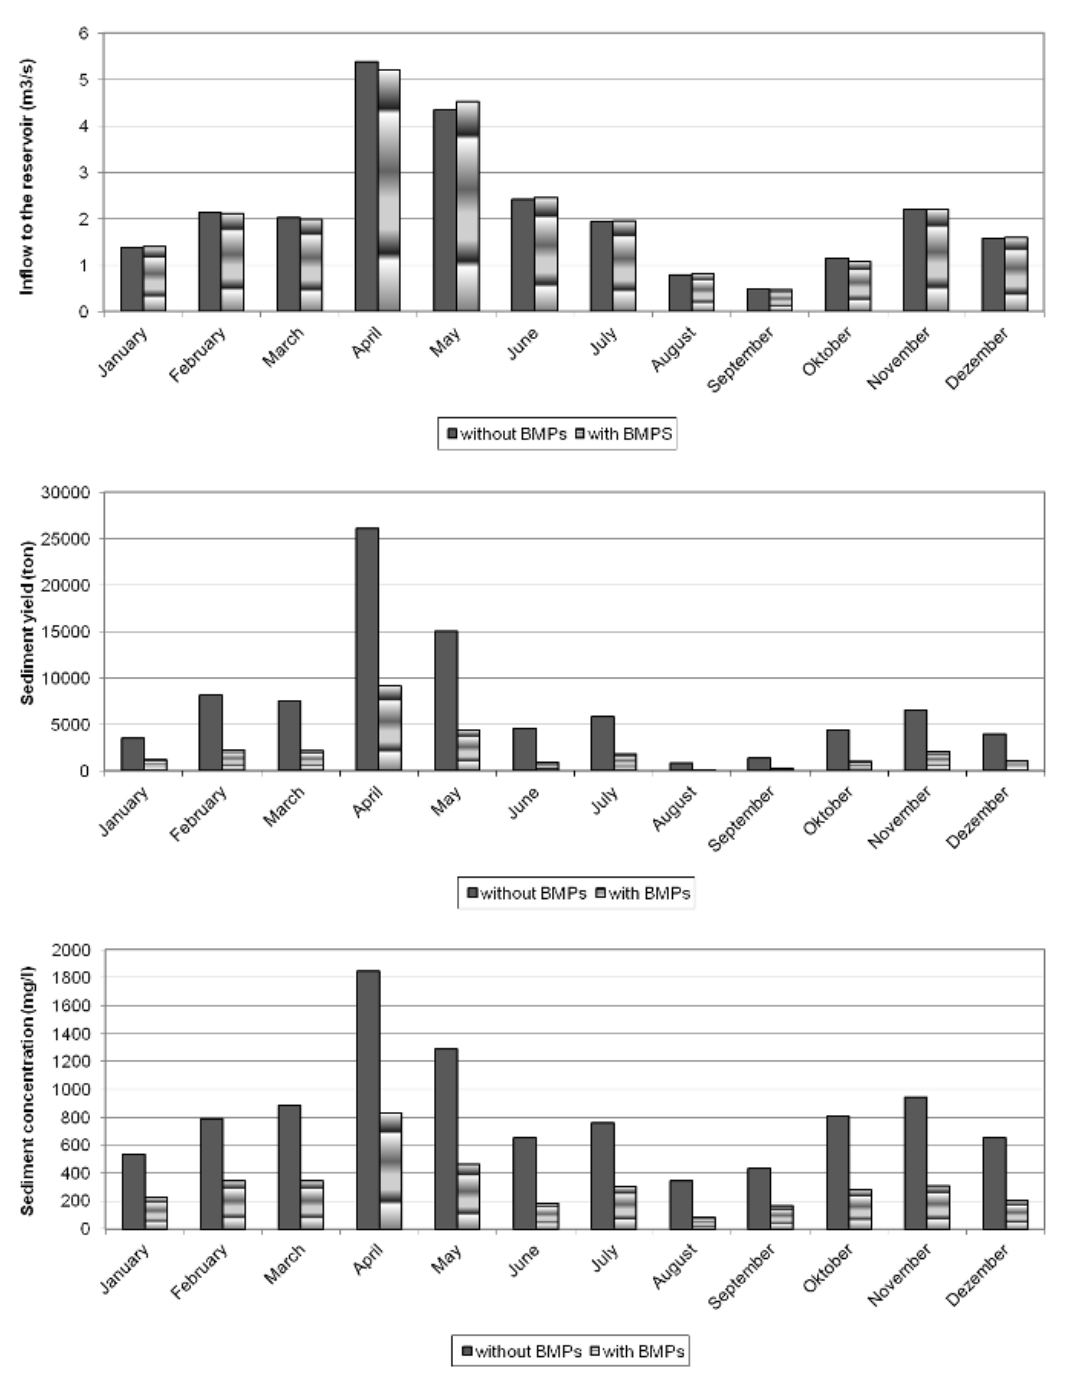
Fig. 4 . Differences in water inflow (above), sediment yield (middle), and sediment concentration (below) with and without best management practices (BMPs) for Scenario